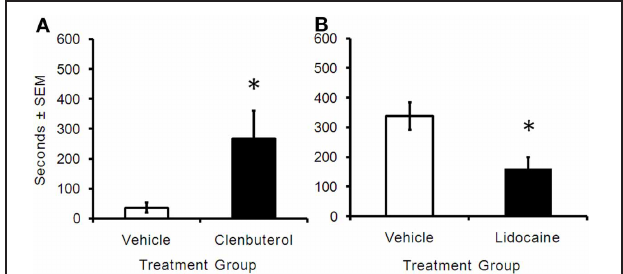
FIGURE 2 | (A) Retention latency times (in seconds) of animals trained on a one-trial inhibitory avoidance task and immediately given intra-BLA infusions of clenbuterol or vehicle. Rats that received infusions of clenbuterol ( m = 267 . 43 ± 93 . 36, n = 7) had a significantly greater cross-over latency 48h later when compared to animals receiving vehicle infusions ( m = 36 ± 16 . 96, n = 6). ∗ p < 0 . 05. (B) Rats given post-training intra-BLA infusions of lidocaine ( m = 162 ± 36 . 91, n = 13) had significantly lower cross-over latencies than animals given vehicle